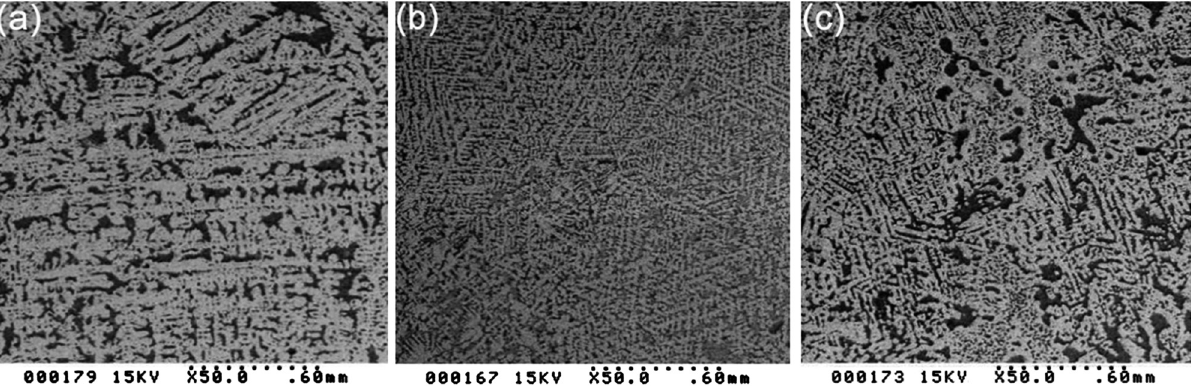
Figure 1: Microstructures of Cu – 37.4 wt% Pb monotectic alloys at di ff erent undercoolings: ( a ) Δ T = 20 K, ( b ) Δ T = 112 K, and ( c ) Δ T = 150